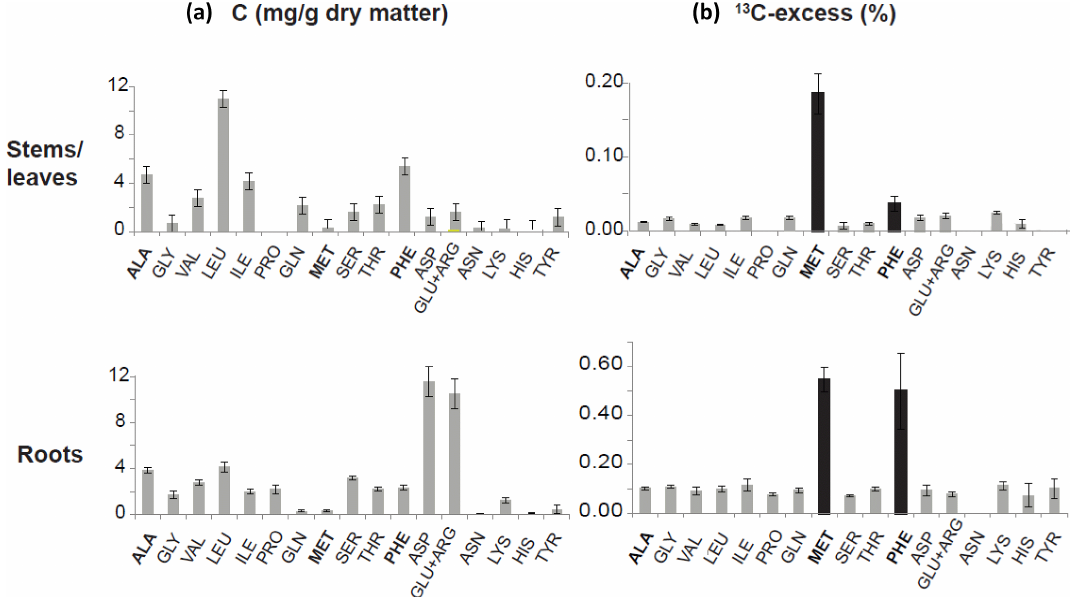
Figure 3. Concentration (a) and 13 C excess (b) of amino acids (AAs) measured by GC-IRMS in roots, stems and leaves. Bars stand for 1 standard deviation of four replicates (2 tanks × 2 AA